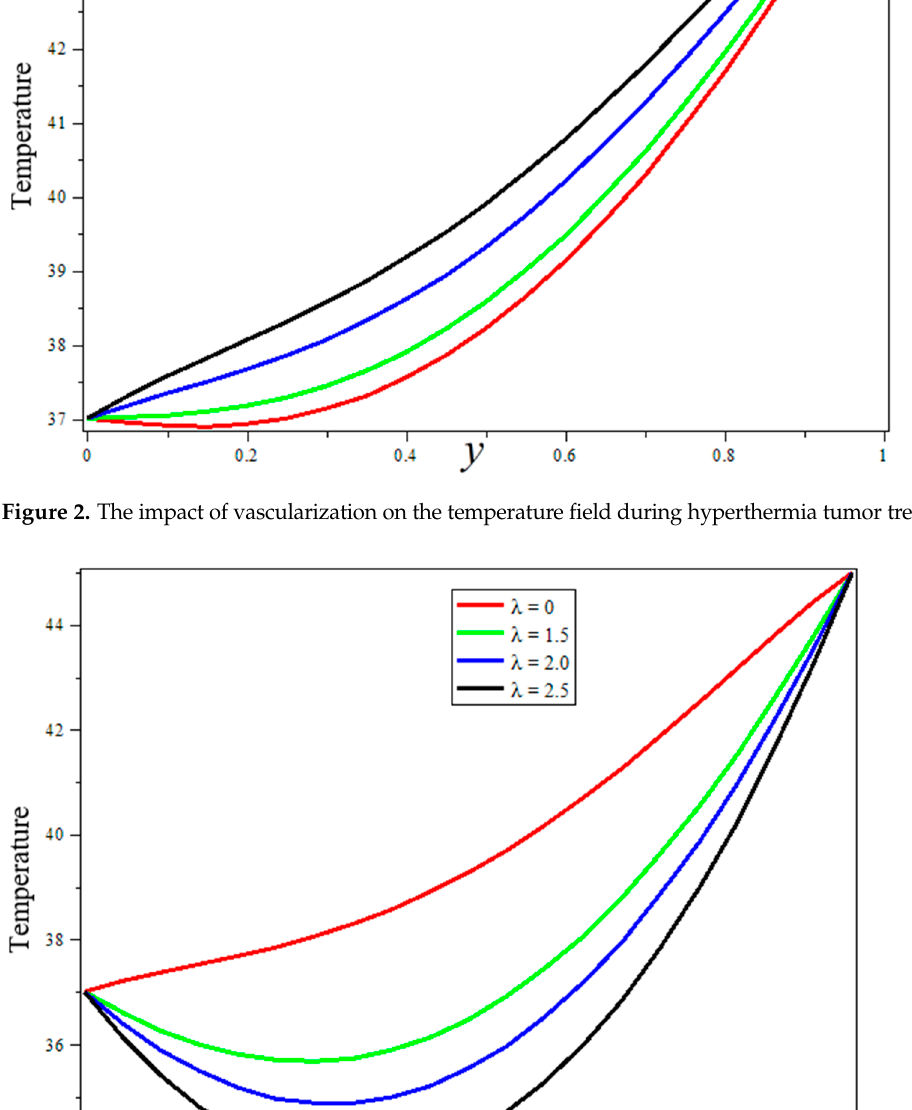
Figure 3. The impact of the source of heat on the temperature field throughout hyperthermia tumor treatment.